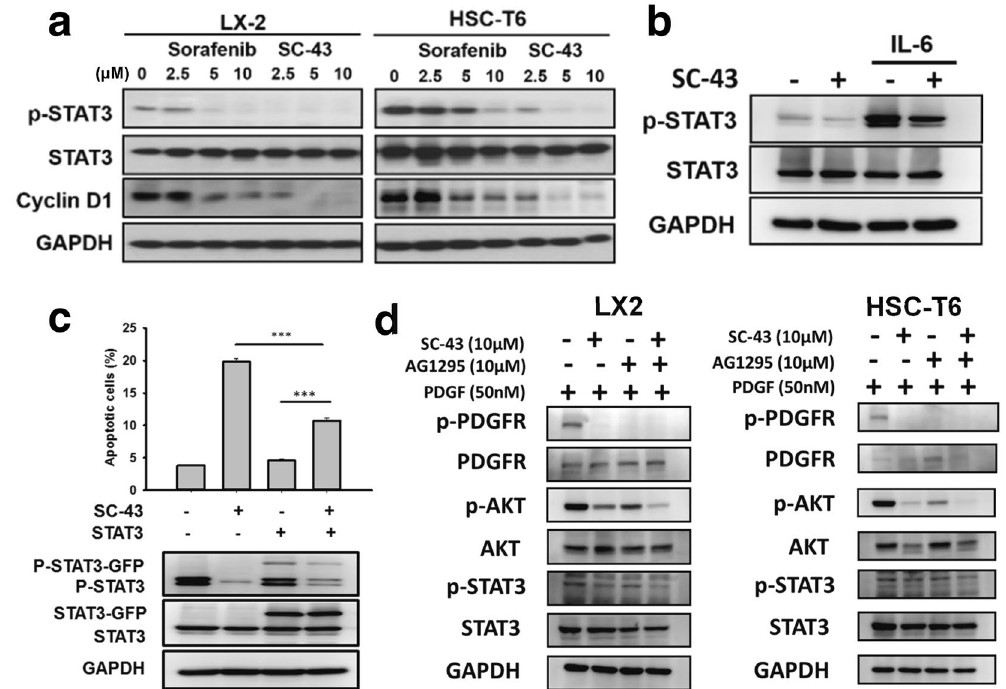
Figure 6. SHP-1 phosphatase plays a major role in SC-43-induced STAT3 inhibition and apoptosis. ( a ) Compared with sorafenib, the SC-43 treatment for 24 h significantly downregulated p-STAT3 and cyclin D1 dose dependently in LX2 and HSC-T6 cells. ( b ) SC-43 downregulated the IL6–STAT3 pathway. ( c ) SC-43- induced apoptosis was reverted in STAT3-overexpressed HSCs. ( d ) After administering AG-1295, a PDGFR specific inhibitor, SC-43 still downregulated p-Akt and